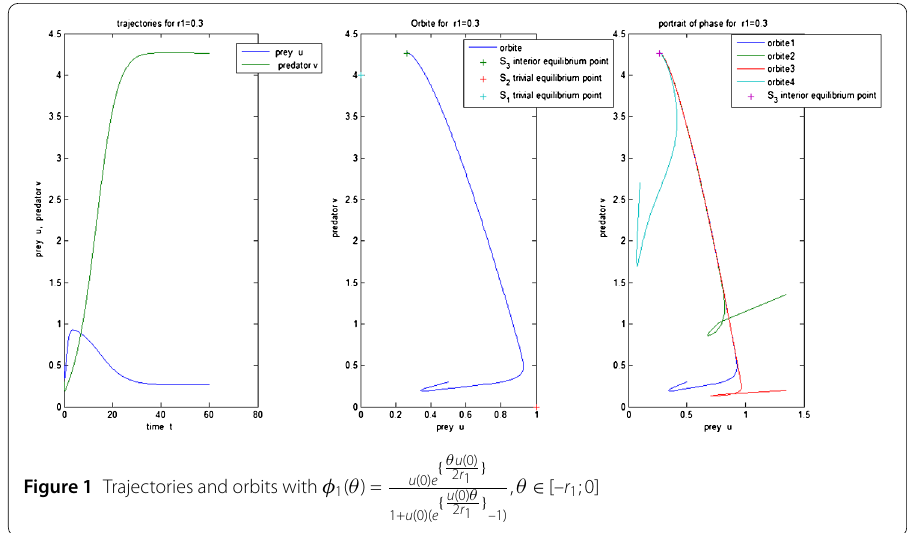
Figure 1 Trajectories and orbits with φ 1 ( θ ) = u (0) e